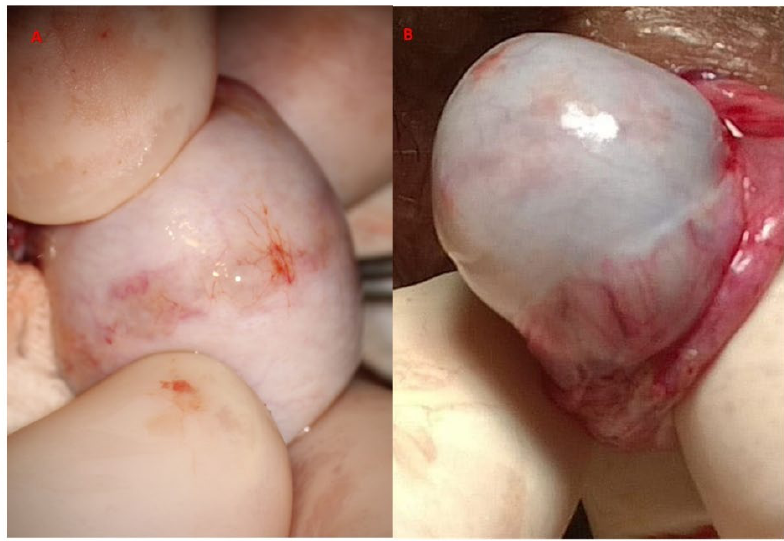
Figure 12. Salvage mTESE after ( A ) one previous failed mTESE ( B ) two previous mTESEs.